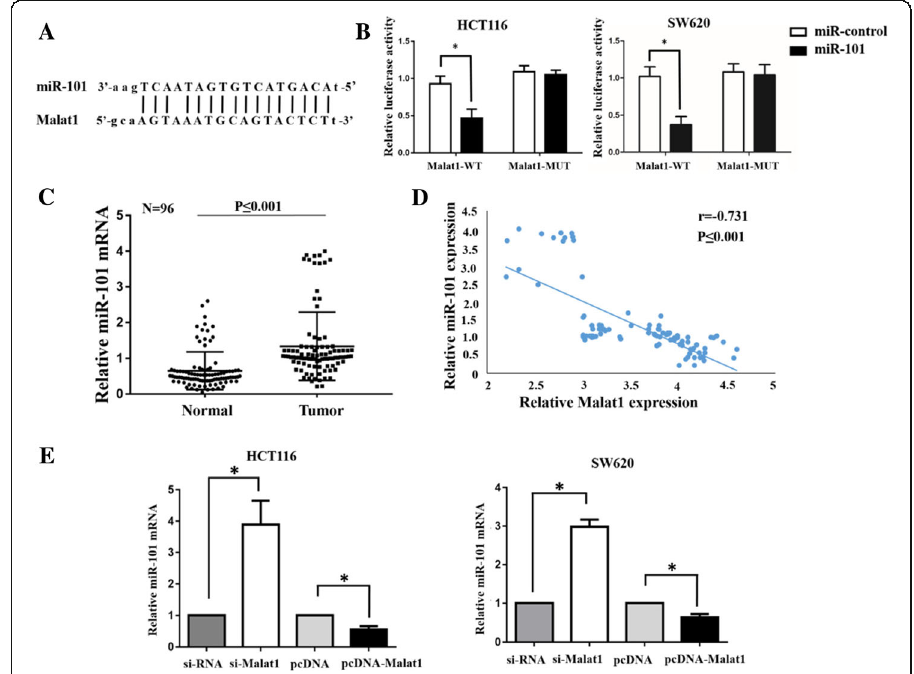
Fig. 4 miR-101 works as a target RNA of Malat1. a-b Dual-luciferase reporter assay shows that co- transfection with miR-101 overexpression mimics significantly reduces luciferase activity of the reporter containing Malat1-WT, but it has less effect on the reporter containing Malat1-MUT in HCT116 and SW620 cells. c qRT-PCR assay shows miR-101 expression in CRC tissues and adjacent normal tissues. d An inverse correlation between Malat1 and miR-101 expression in CRC tissues. e qRT-PCR assay shows the effects of Malat1 down-regulation or up-regulation on miR-101 expression in HCT116 and SW620 cells. The columns show the mean for three separate experiments. Bars, sd. * p < 0.05, ** p <